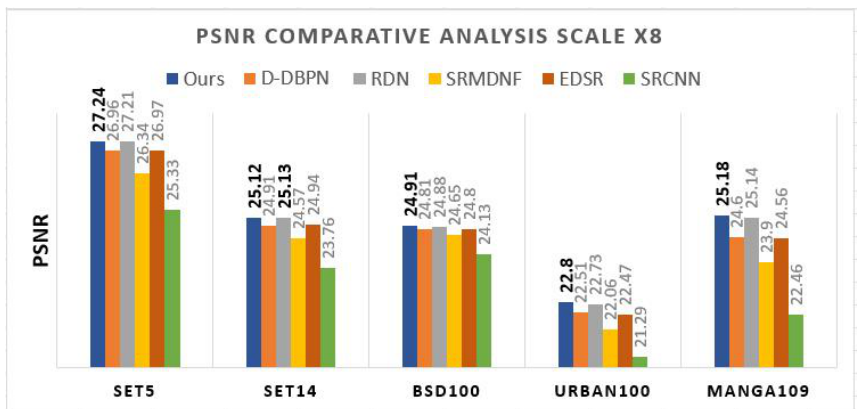
Figure 18. PSNRcomparison at × 8 scale.